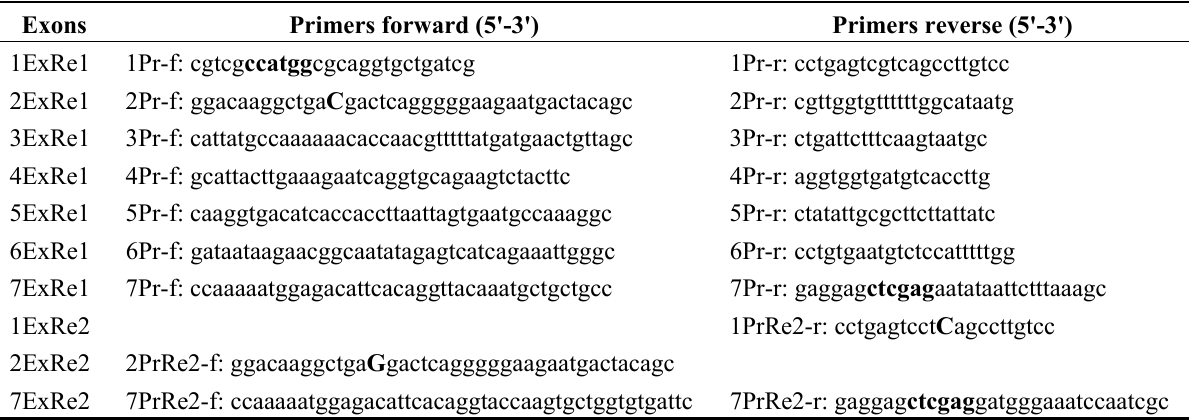
Figure 3. Joining of hRenalase1 exons into the full-length coding sequence. Agarose gel electrophoresis of PCR products of hRenalase1 exons obtained during Step 2. The calculated sizes of the amplified exons (corrected for the presence of the OS